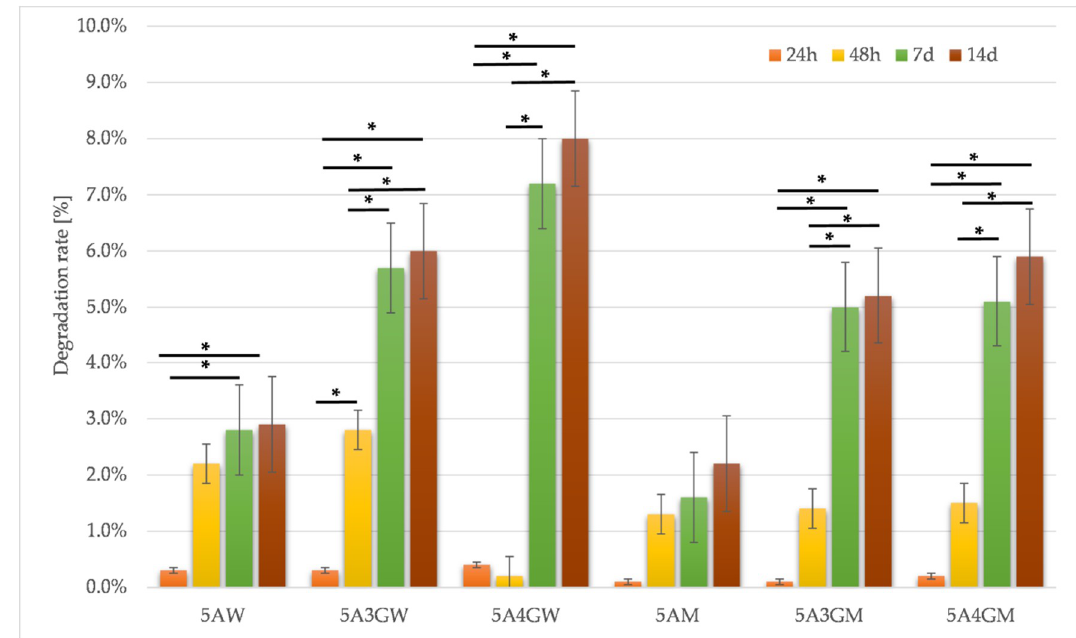
Figure 3. Degradation rates for samples dissolved in water (W) and full culture medium (M) with different content of gelatine evaluated after 24 h, 48 h, 7 days, and 14 days of incubation (* = p < 0.05, results statistically significant).